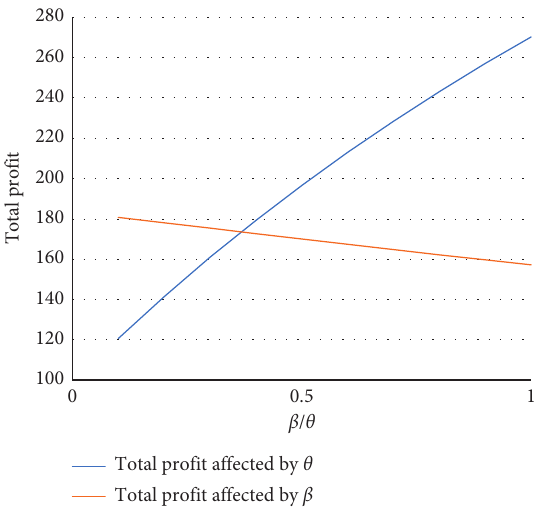
Figure 4: The influence of parameters β and θ on total